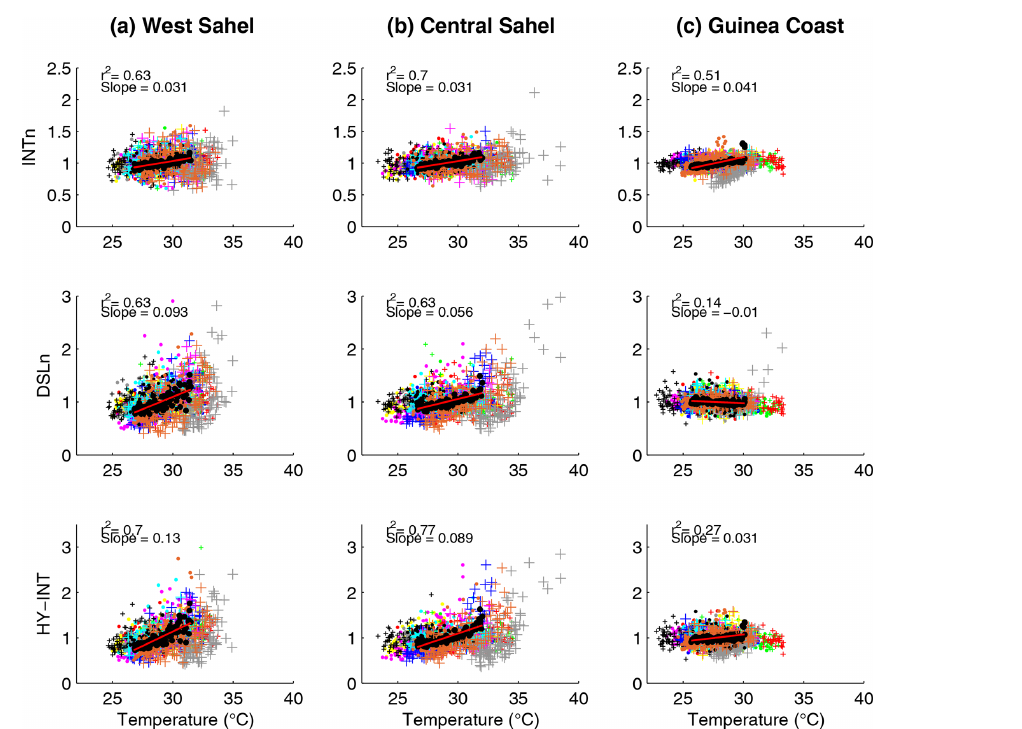
Figure 4. Annual values of INTn, DSLn, and HY-INT ( y axis) shown against annual mean temperature ( ◦ C) ( x axis), and averaged over (a) West Sahel, (b) Central Sahel, and (c) Guinea Coast. Each color corresponds to a single simulation, as described in Table 1, and the thick black dots correspond to the multimodel mean. Also shown are the fitted regression line of the multimodel mean (red line) and the associated coefficient of determination (“ r 2 ”) and correlation